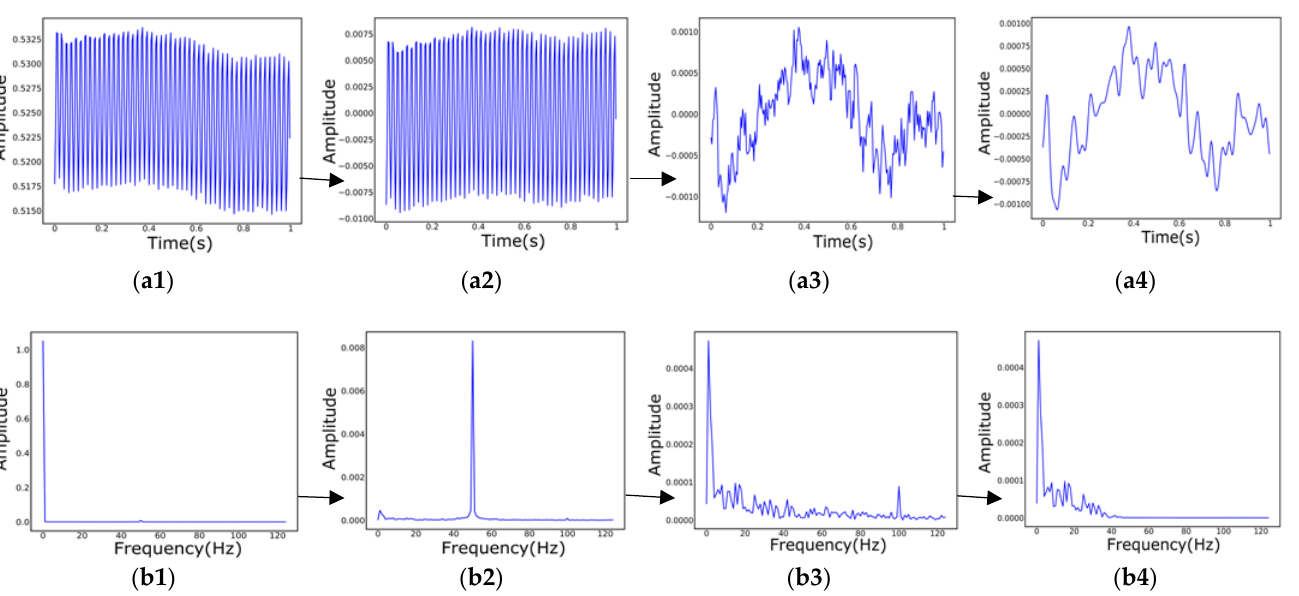
Figure 4. The filtering time and frequency diagram of the preprocessing process (the above shows the filtering process of the Fpz electrode EEG of sample data (subject ID: 02010005). In the time domain filtering process, axes are added to each filter map when displayed. However, the axes are not needed for RGB synthesis to exclude the influence of other factors of the synthesis map on the experimental results). ( a1 – a4 ) Time domain filtering process; ( b1 – b4 ) The four graphs are, respectively, the frequency domain waveforms of the time domain graphs ( a1 – a4 ).